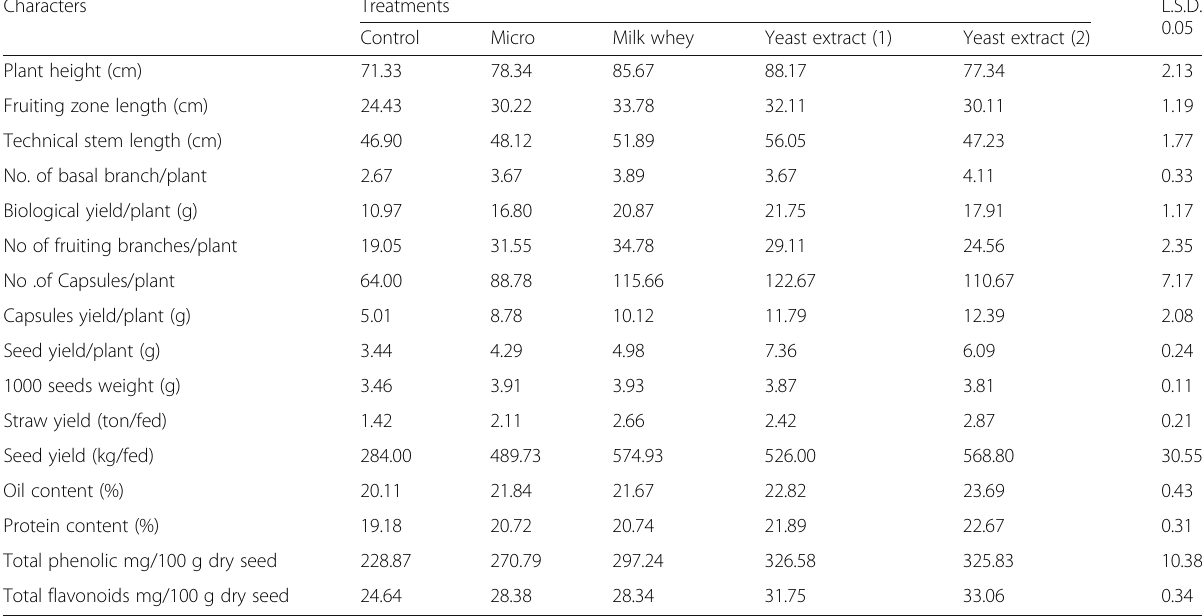
Table 6 Effect of bio-fertilizer treatments on seed yield, its related characters, and nutritive value of flax plants grown under sandy soil conditions Characters Treatments